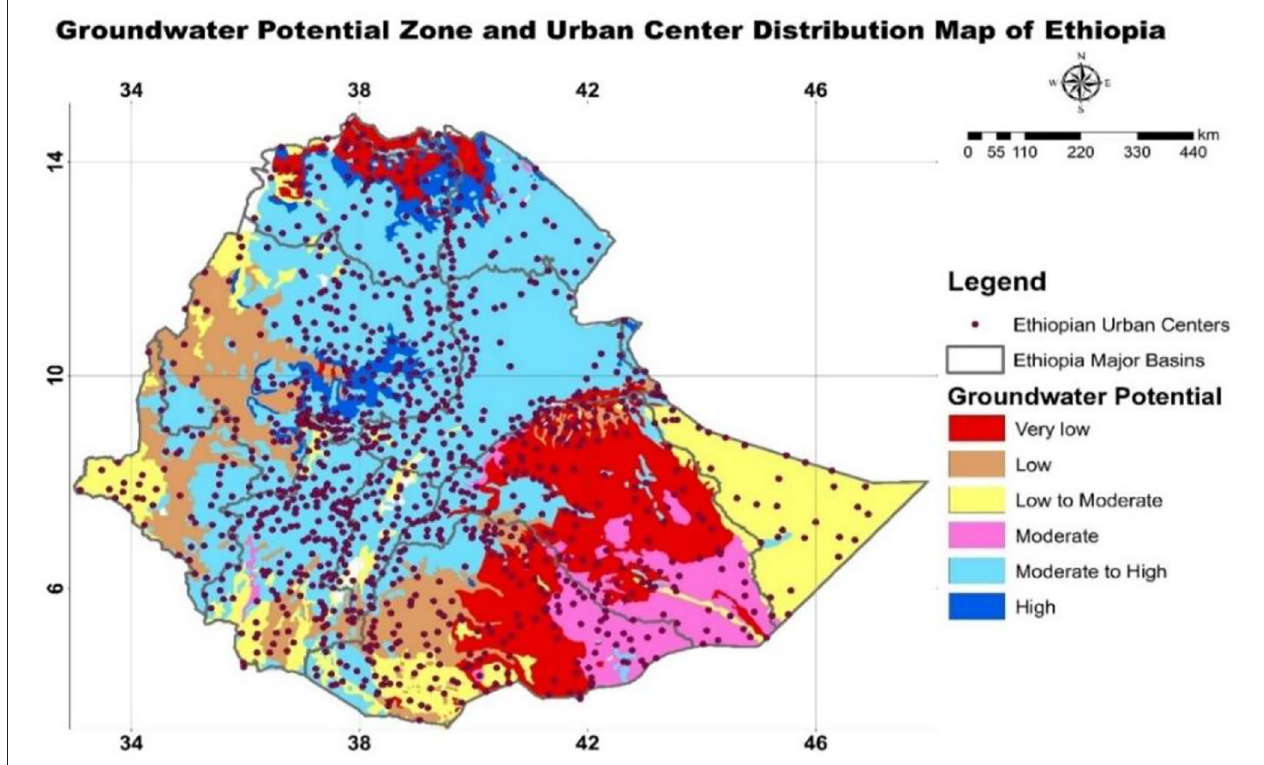
FIGURE 5 | The groundwater resource potential of Ethiopia. Source: FDRE National Planning Commission (2016), Kebede et al.